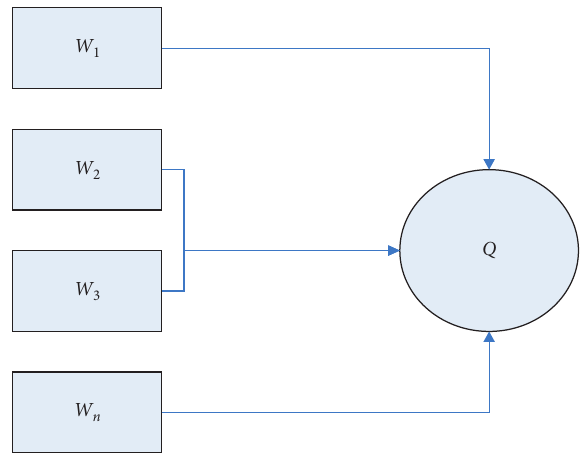
Figure 2: Adaptive weighted fusion